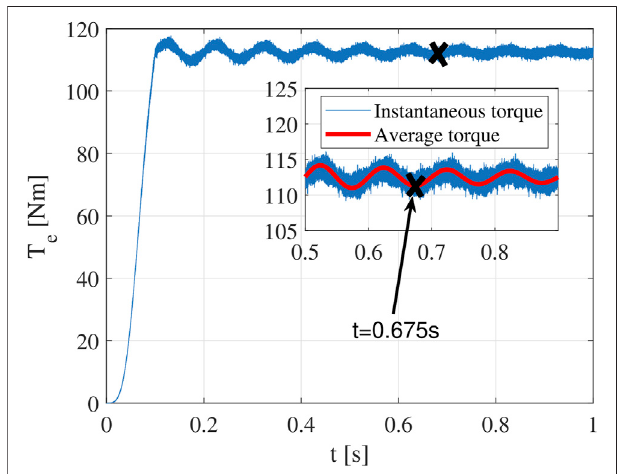
FIGURE 8 | Torque of the ramp function I s method (FEA result).